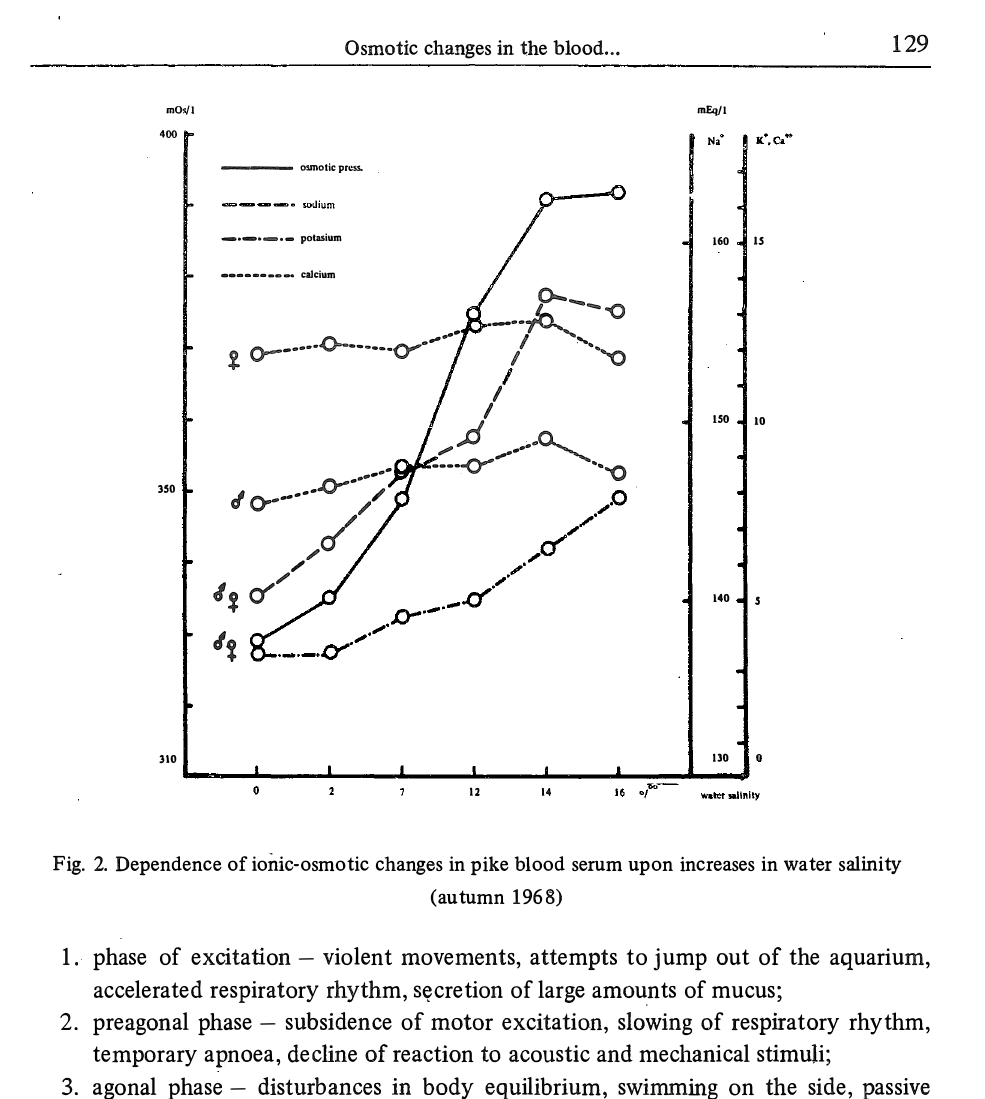
Fig. 2. Dependence of ionic-osmotic changes in pike blood serum upon increases in water salinity (autumn